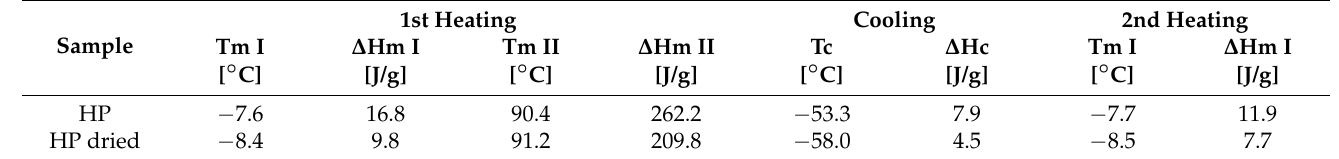
Figure 4. DSC thermograms of not dried (HP) and dried (HP dried) hazelnut skin samples: ( a ) first heating scan; ( b ) second heating scan. Table 3. DSC thermal parameters of not dried (HP) and dried (HP dried) hazelnut skin samples.